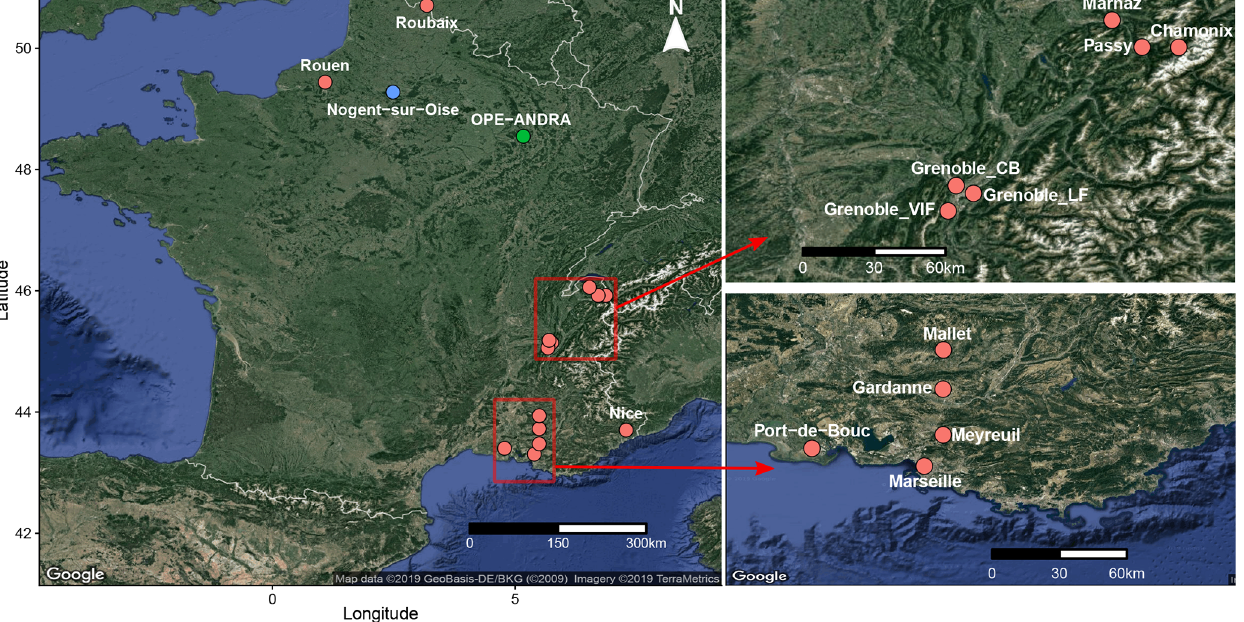
Figure 1. Geographical location of the selected sampling sites. The red and blue dots indicate urban and suburban sites, respectively, while the green one corresponds to a rural site, surrounded by field crop